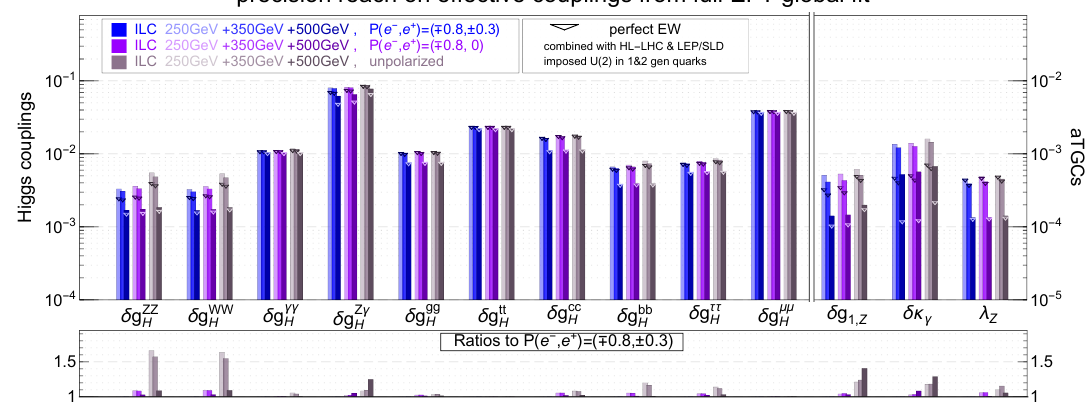
Figure 7 . Global one-sigma reach on Higgs and triple-gauge couplings at the ILC, for three di(cid:11)erent beam polarization con(cid:12)gurations. Electroweak measurements from LEP and SLD as well as HL-LHC projections are included in all scenarios. Electroweak parameters (not shown) are marginalized